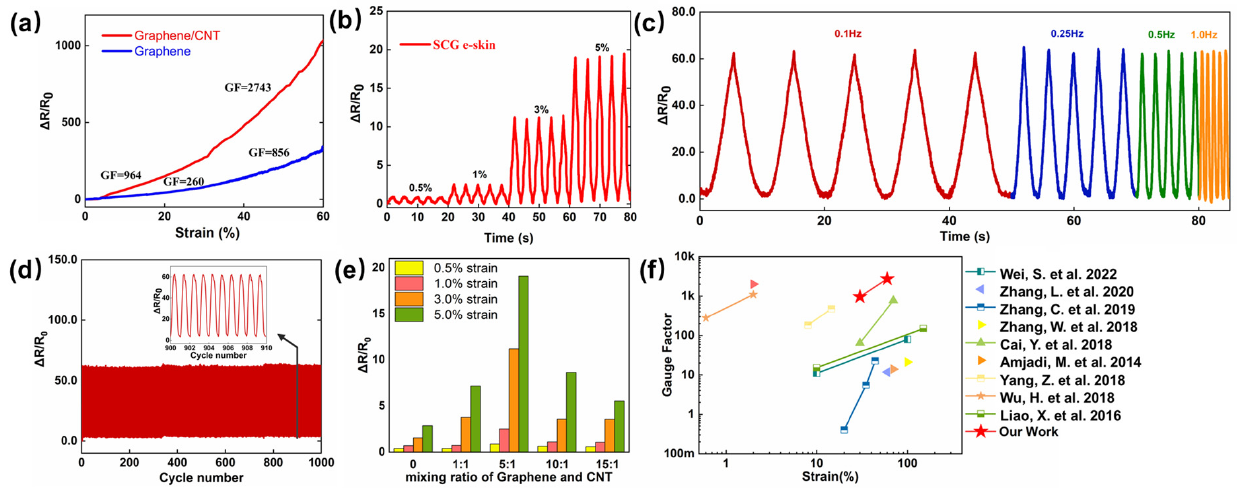
Figure 2. Electromechanical performance of SCG e-skin. ( a ) Relative resistance variation of SCG e- skin and graphene e-skin. ( b ) Relative resistance variation under different cyclic strains at a frequency of 0.25 Hz. ( c ) Relative resistance variation of SCG e-skin under cycle stretching–releasing with a strain of 10% at frequencies of 0.1, 0.25, 0.5, and 1.0 Hz. ( d ) Relative resistance variation with the cyclic strain of 10% for 1000 cycles. ( e ) The maximum resistance variation of different mixture ratios of graphene and SWCNTs (1:1, 5:1, 10:1, 15:1, and pure graphene) under the strain of 0.5–5%. ( f ) Comparison of sensitivity-strain characteristics with others